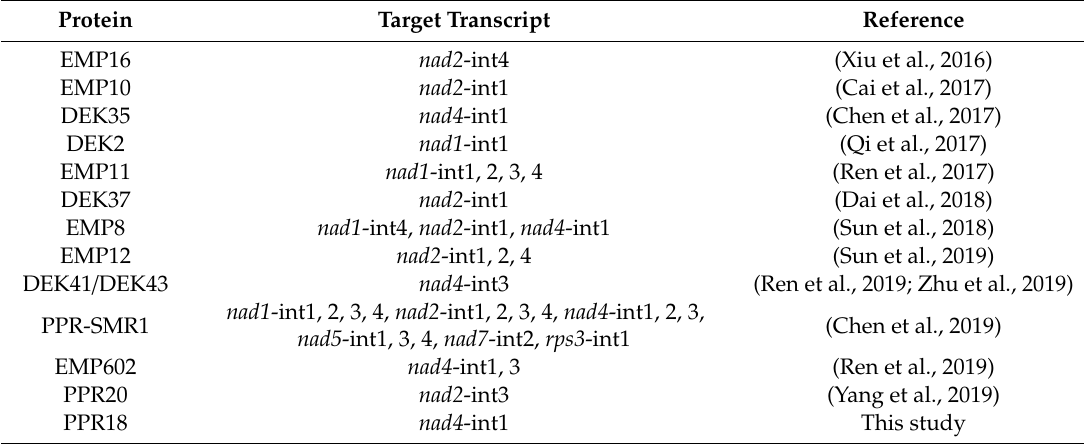
Table 2. List of mitochondrion-localized PPR proteins are involved in intron splicing of mitochondrial genes in